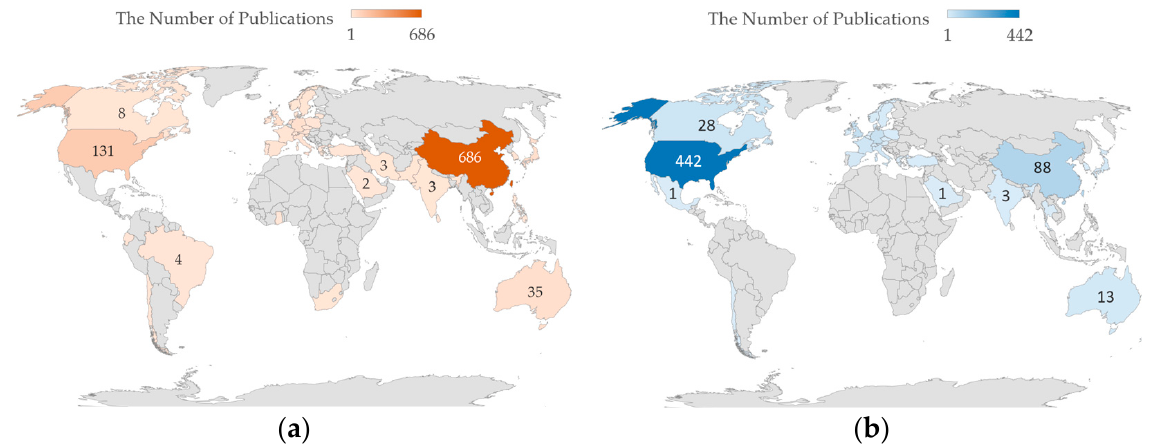
Figure 11. International distribution of publications with national names as keywords. ( a ) national distribution of publications with ‘China’ as keyword; ( b ) national distribution of publications with ‘US’ as keyword.